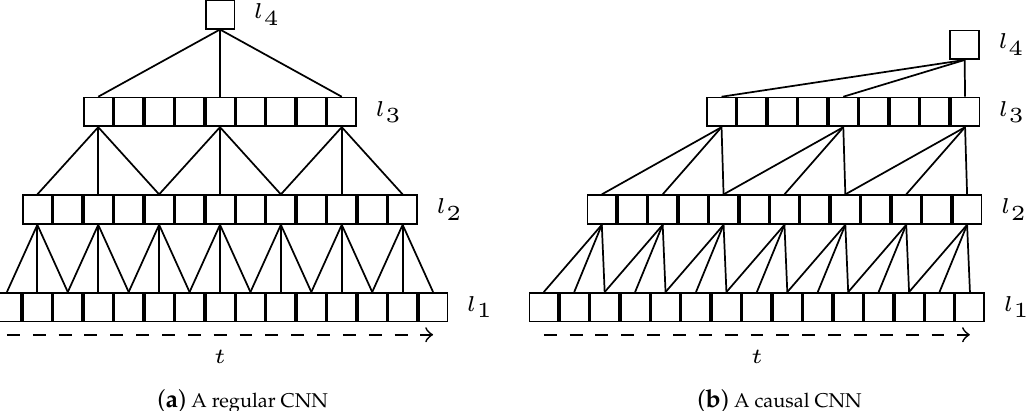
Figure 6. Comparison between a regular and a causal convolutional neural network, with dilatation coefficient 2. ( a ) Sample regular convolutional neural networks (CNN). ( b ) Sample of the proposed causal CNN. t : Temporal order of the input sequence. l 1 : First layer (input sequence). l 2 , l 3 , l 4 : Subsequent convolutional layers.